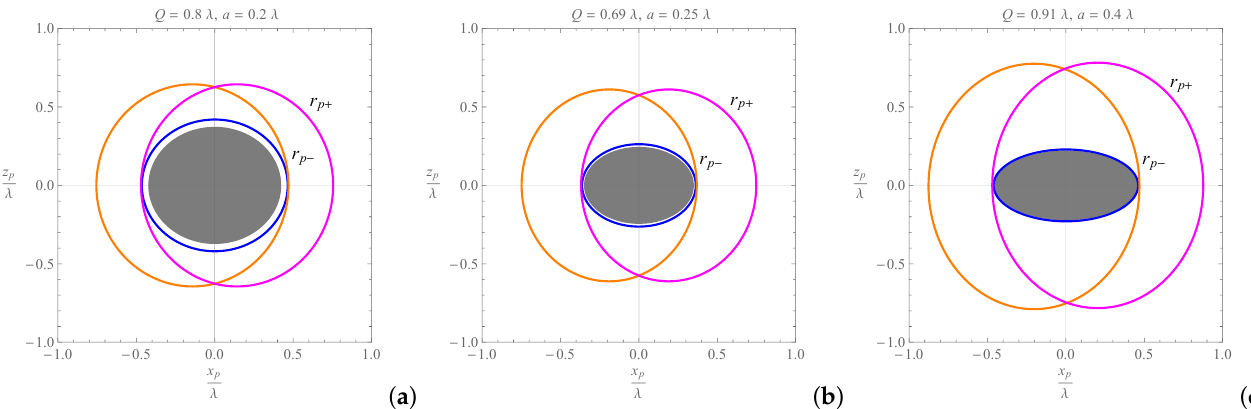
Figure 5. The shape of the photon regions ( r p − < r < r p + ), as viewed from the y axis, plotted for λ = 10, and different values of Q and a . The event horizon r + occupies the central shaded region and is encompassed by the rings r p − and r p + . The blue contour corresponds to the boundary of the inner ring r p − , which coincides with the event horizon, only for the extremal black hole with Q = Q ex and r p − = r + = r ex